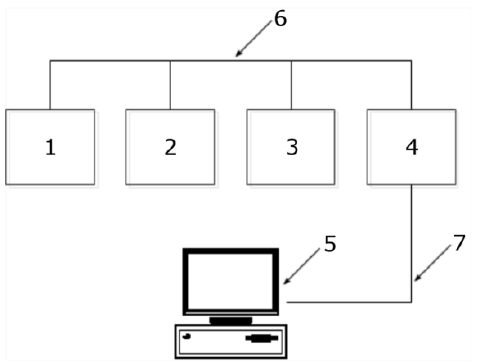
Figure 6. The configuration of the communication between modules and the computer (1,2,3—modules used to measure orientation, 4—master module, 5—superior system, 6—communication interface, 7—USB interface).